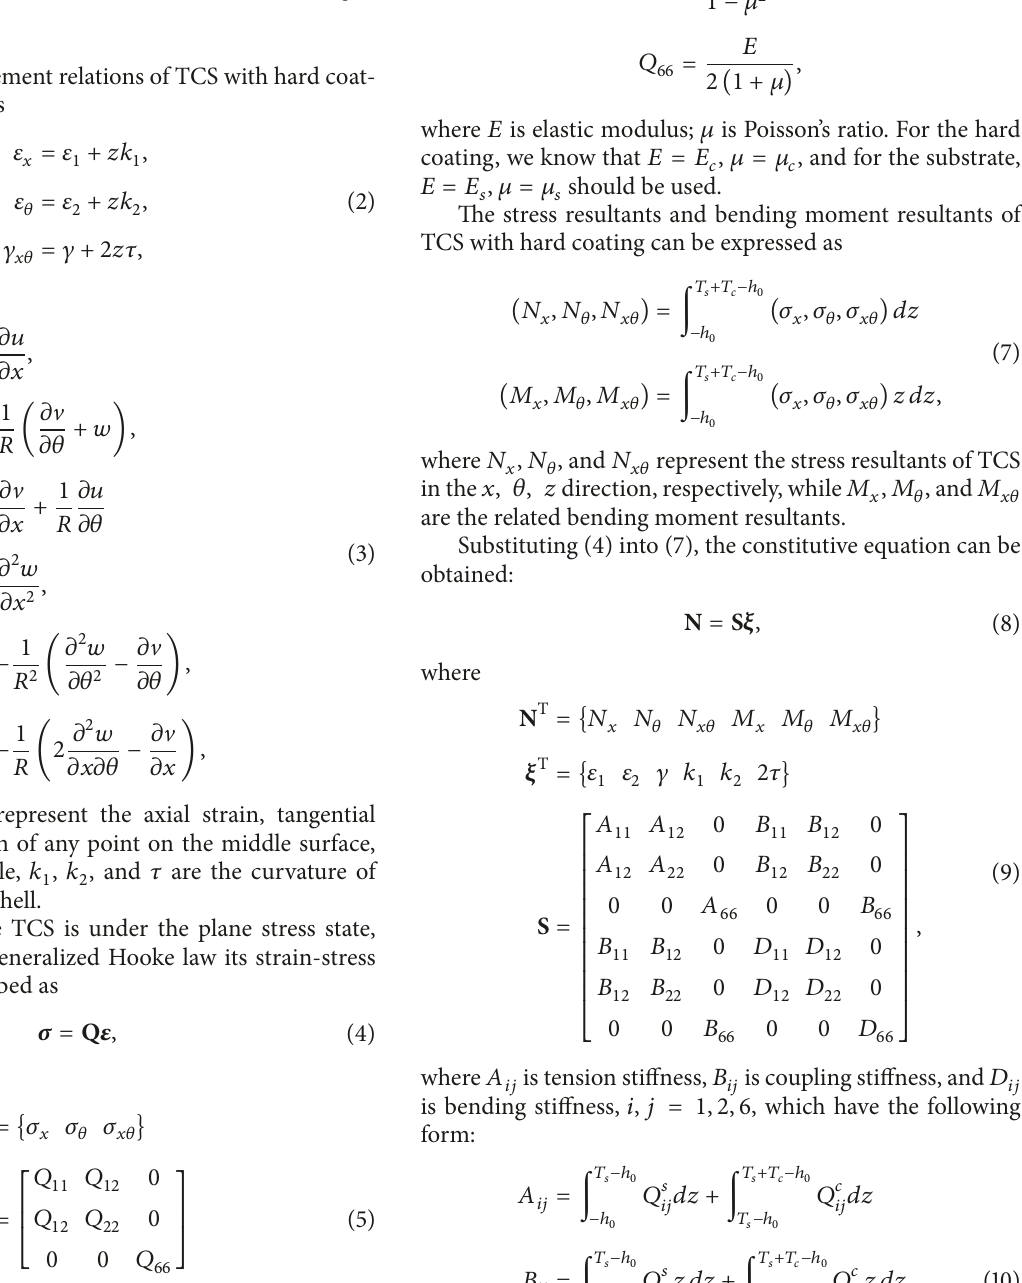
Figure 3: Schematic of cross section of TCS with hard coating.